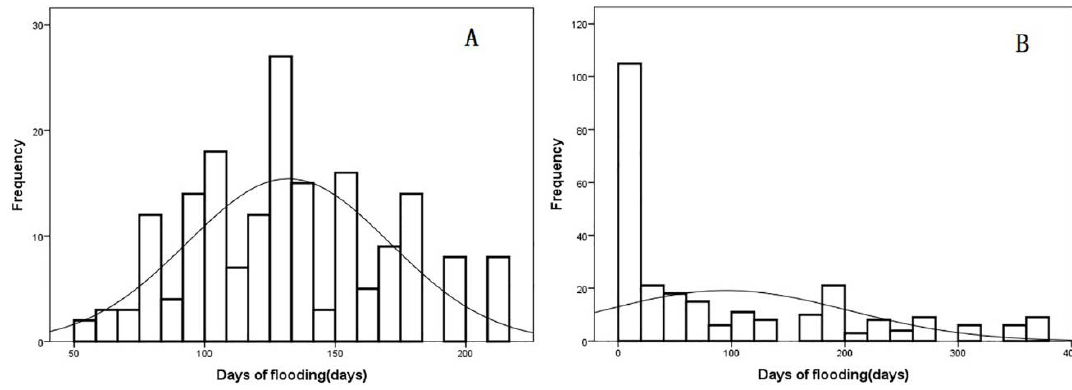
Figure 3. Histograms of the days inundated with water in the two areas. Number of days inundated with water in the areas with snails ( A ) and without snails ( B ). Table 2. Generalized Additive Model of factors affecting the distribution of